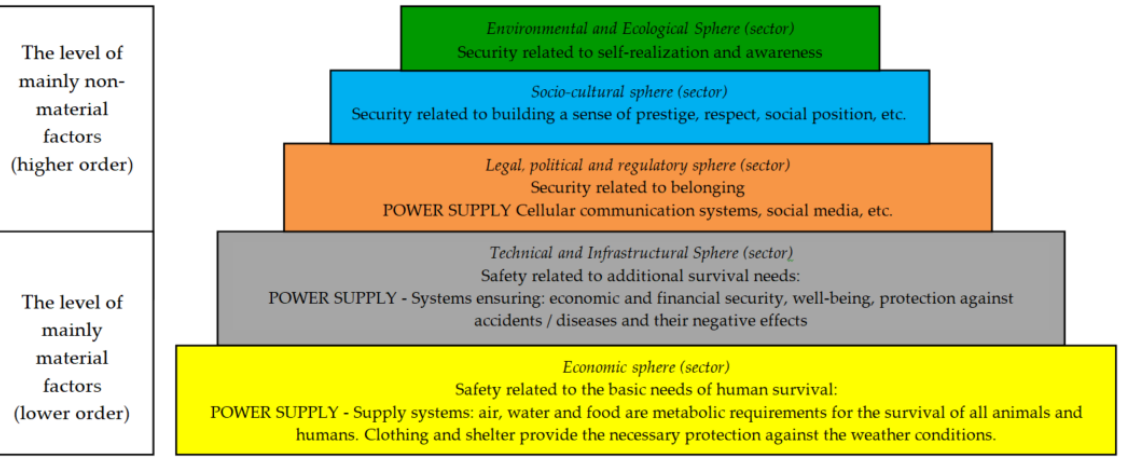
Figure 2. The pyramid of needs of security types based on the concept of the hierarchy of needs proposed by Maslow. Source: own study. Green color — environmental sphere of the energy posed by Maslow. Source: own study. Green color —environmental sphere of the energy market. market. Blue color — social sphere of the energy market. Orange color — political sphere of the Blue color —social sphere of the energy market. Orange color —political sphere of the energy energy market. Gray color — technological sphere of the energy market. Yellow col- market. Gray color —technological sphere of the energy market. Yellow color —economical or — economical sphere of the energy market. sphere of the energy